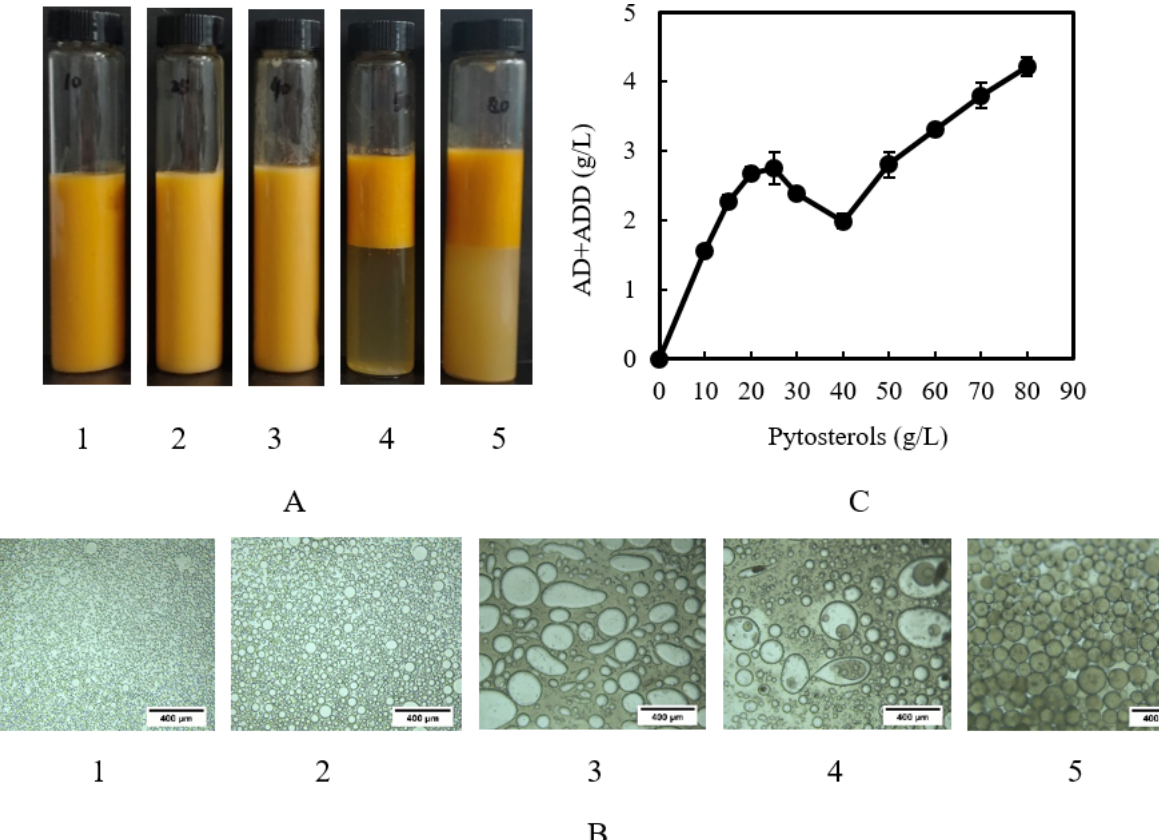
Figure 4. Microbial transformation with various phytosterol loadings: ( A ) Emulsion fraction. ( B ) Microscopic emulsions (bar = 400 μ m). ( C ) AD and ADD concentrations. In the basic experimental condition, the volume ratio of soybean oil to the aqueous culture medium was 15:35 mL. The glucose concentration in the aqueous culture medium was 10 g/L. The microbial transformation time was 7 days. No. 1, 2, 3, 4, and 5 corresponded to phytosterol concentrations in the soybean oil of 10, 25, 40, 50, and 80 g/L, respectively.